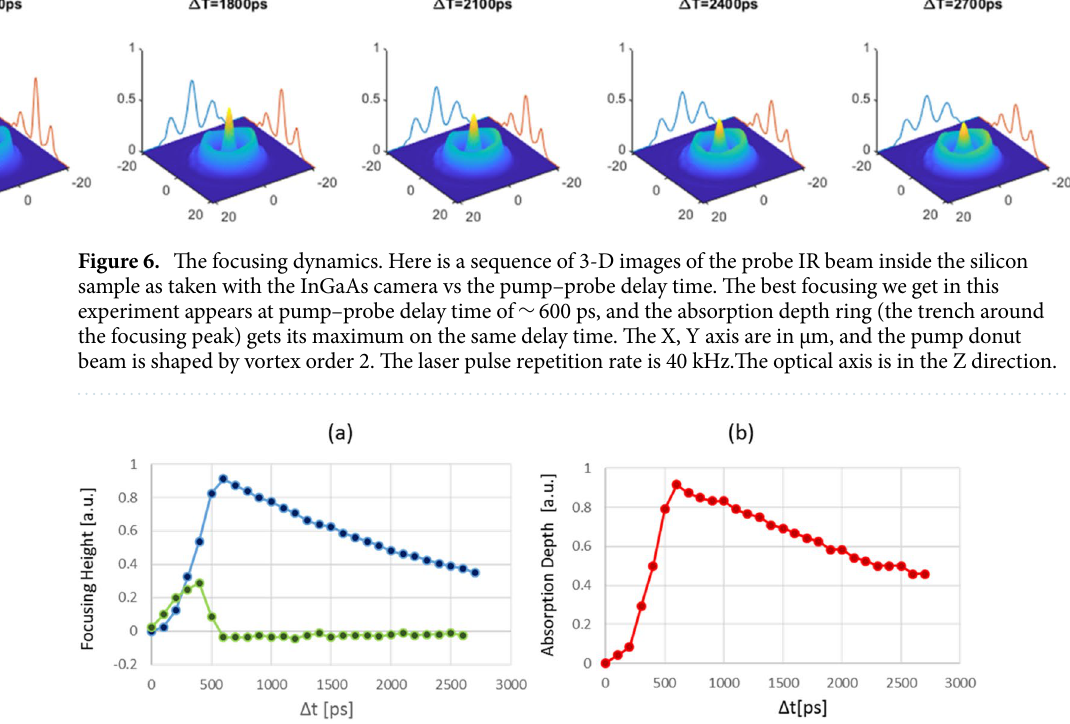
Figure 7. Time evolution analysis of the FCC focusing ( a ) and absorption ( b ). It was taken from the same data as in Fig. 6. In ( a ) are shown the focusing peak’s height (blue) and its derivative (green) versus the pump–probe delay time. In ( b ) is given the donut ring absorption depth seen in Fig. 6 that represents the absorption of the probe beam by the FCCs donut shape that is induced by the pump beam.